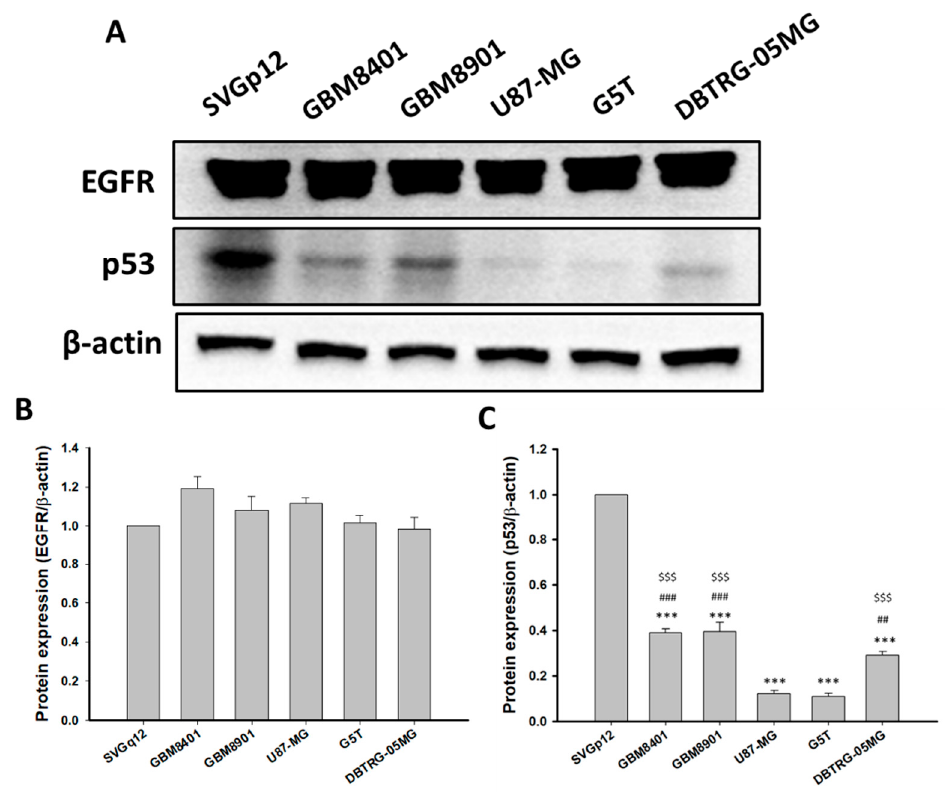
Figure 5. EGFR and p53 protein expressions in all tested astrocytoma cell lines (n = 6). ( A ) Western blot of EGFR and p53. ( B ) Relative EGFR protein expression levels. ( C ) Relative p53 protein expression levels. Expression levels were normalized to p53 expression in SVGp12 cells. *** p < 0.001 compared with the SVGp12. ## p < 0.01 and ### p < 0.001 compared with the U87-MG. $$$ p < 0.001 compared with